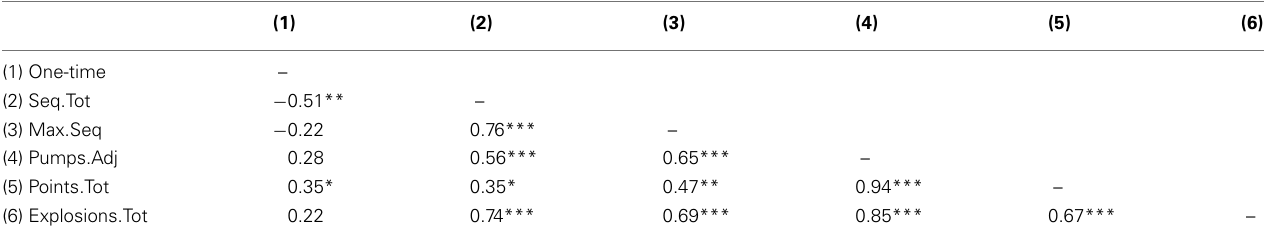
Table 1 | Pearson’s correlations among different BART performance